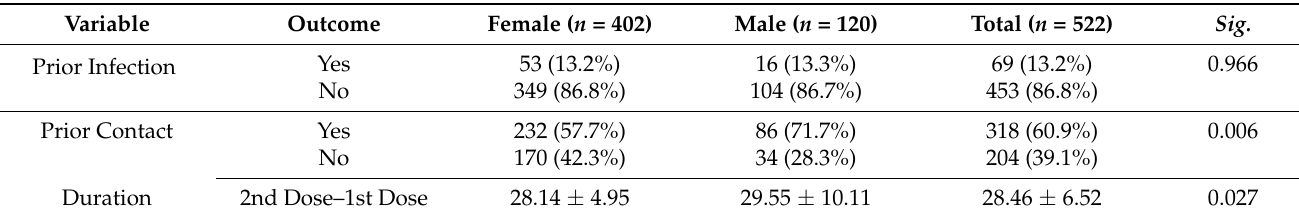
COVID-19-related anamnesis of Slovak healthcare workers who received BNT162b2, February–March 2021 ( n =